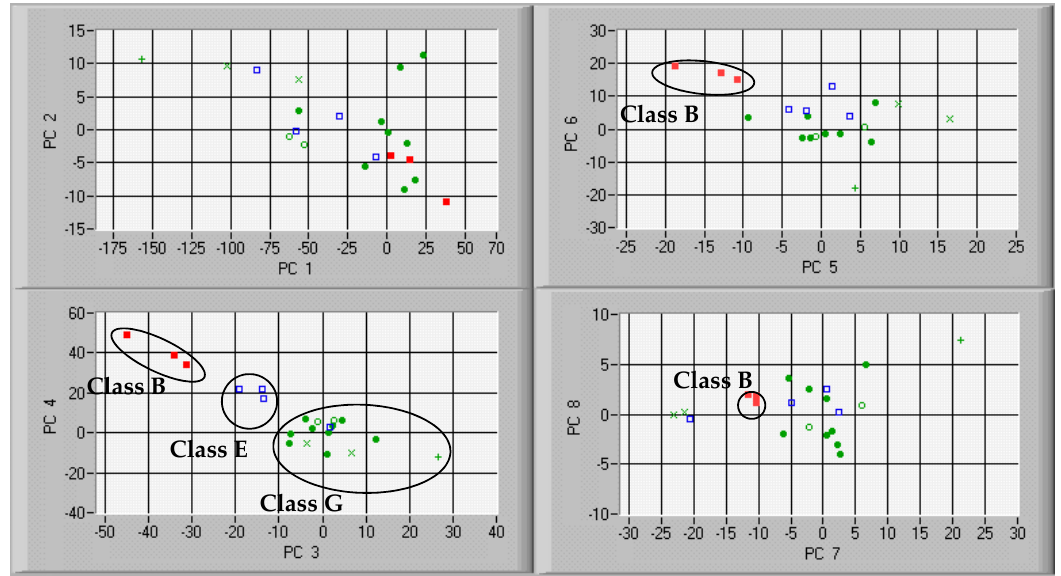
Figure 8. Representation of devices by PC1–PC8 for acquisition time equal to 4 min.